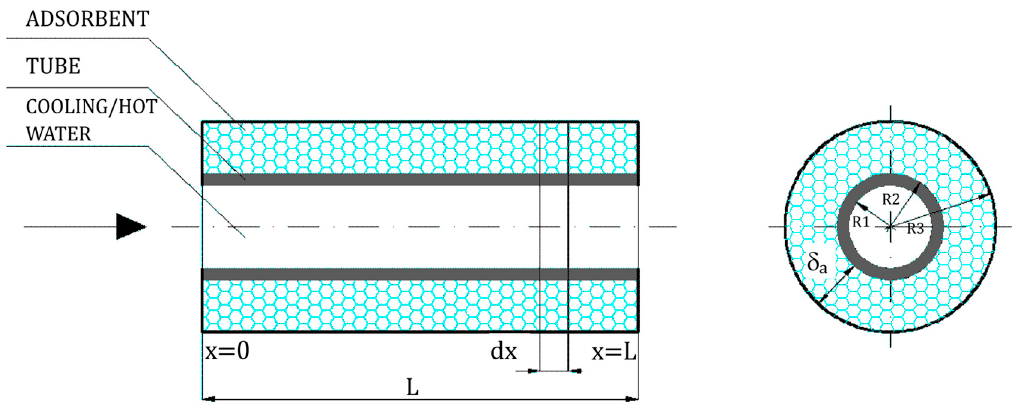
Figure 2. Design of the adsorber/desorber element (tube with deposited silica gel bed).